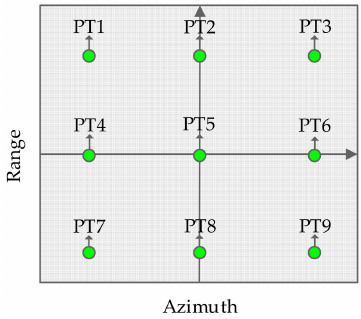
Figure 7. Distribution of targets in the illuminated spot matrix which contained nine-point targets.